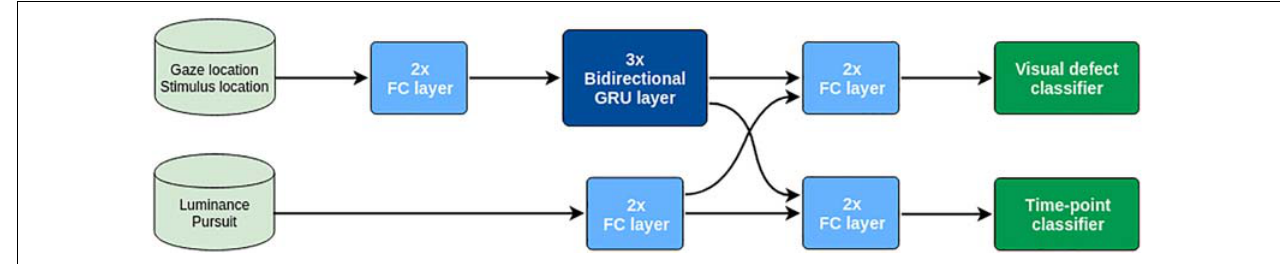
FIGURE 4 | Schematic representation of the architecture of the deep recurrent neural network.